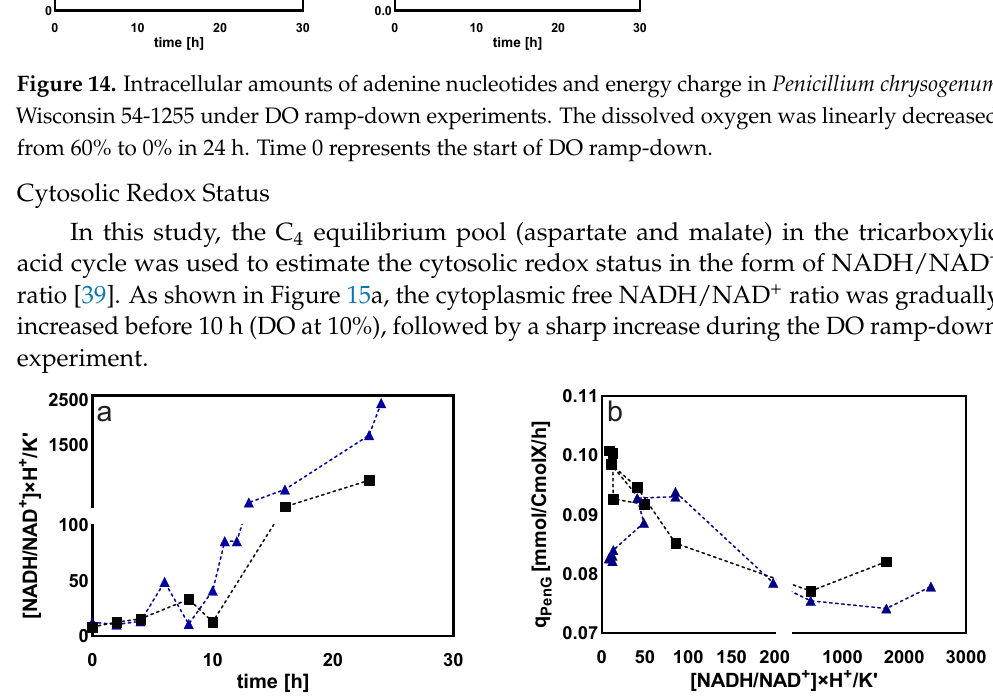
Figure 15. ( a ) Calculated cytoplasmic free NADH/NAD + ratio, assuming a constant intracellular pH and equilibrium constant K (cid:48) . The dissolved oxygen linearly decreased from 60% to 0% over 24 h. Time 0 represents the start of DO ramp-down. Two legends represent two replicate experiments. ( b ) q as a function of NADH/NAD + ratio during the DO ramp-down PenG